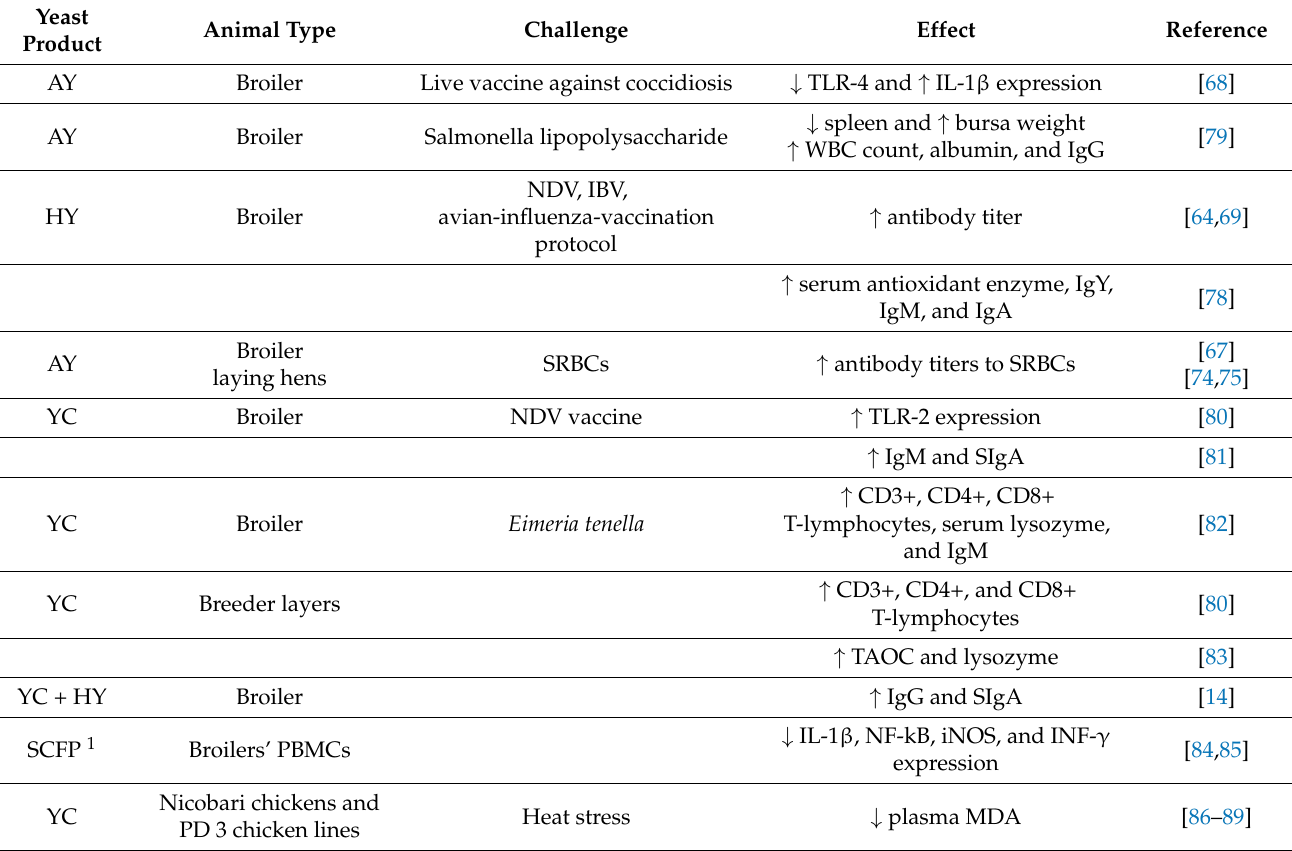
Table 1. Main effects of hydrolyzed-yeast (HY), autolyzed-yeast (AY), and yeast-culture (YC) admin- istration on the immune response of